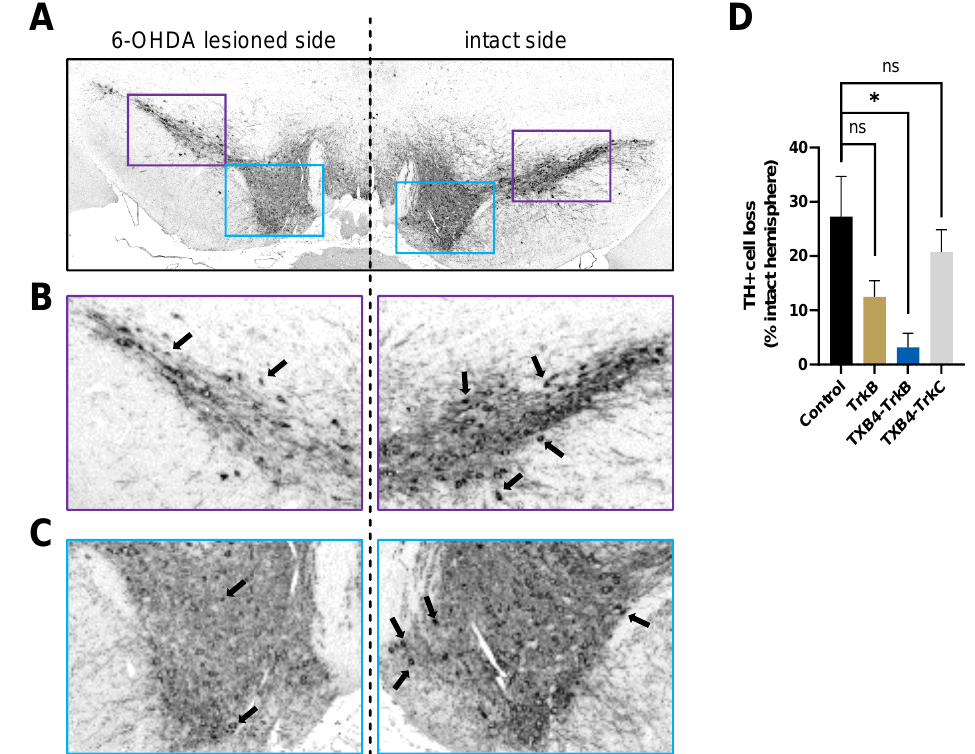
Figure 5. TXB4-TrkB protects dopaminergic cell bodies in the substantia nigra (SNc) against neuronal loss in the 6-OHDA model of PD. Representative section of TH+ dopaminergic SNc cells within the 6-OHDA lesioned (left) and intact (right) sides of PBS control ( A ) at 20× magnification. Enlargements of the boxed areas of lateral ( B ) and medial regions ( C ) show examples of the TH+ cell bodies (arrows) counted per section. Cell loss within the 6-OHDA lesioned side relative to the control side is shown ( D ) for groups treated with PBS, TrkB agonist antibody, TXB4-TrkB or TXB4-TrkC fusion antibodies. Data represented as mean ± SEM % TH+ cell loss relative to intact hemisphere ± SEM. One-way ANOVA, Tukey’s HSD, * p = 0.035, n = 3–5 mice per group, ns = not